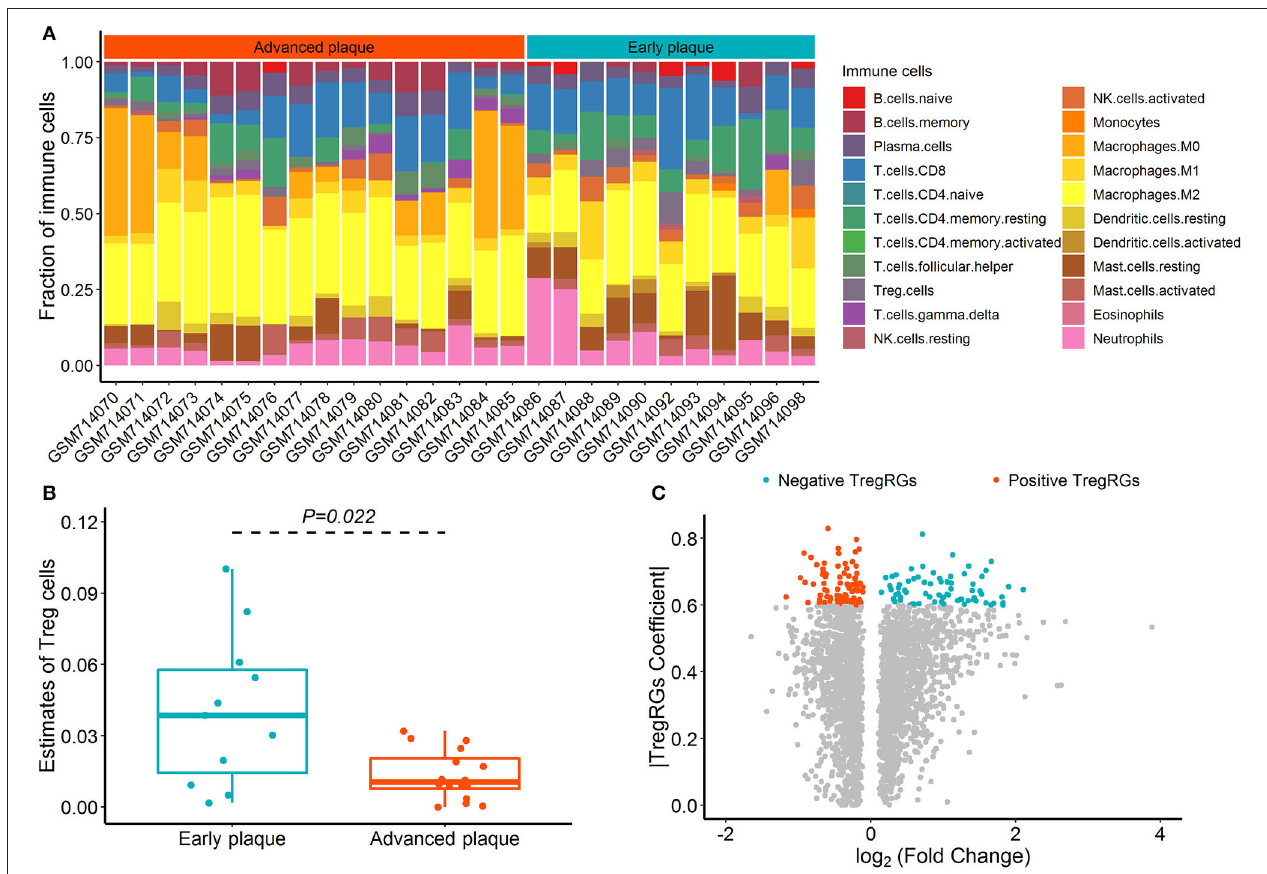
FIGURE 1 | Identification of DETregRGs in advanced and early atherosclerotic plaques. (A) Abundance of 22 immune cells across 27 samples estimated by the CIBERSORT algorithm. (B) Fraction of Tregs between 11 early and 16 advanced plaque samples. (C) Volcano plot for the differentially expressed genes between 13 early and 16 advanced plaque samples. DETregRGs, differentially expressed Tregs-related genes; Tregs, regulatory T cells; TregRGs, Tregs-related